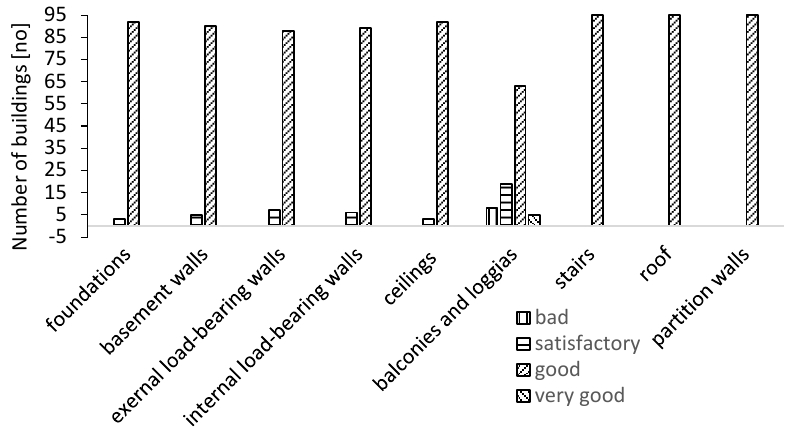
Figure 12. Technical state of bearing elements (based on the information provided in [76]).